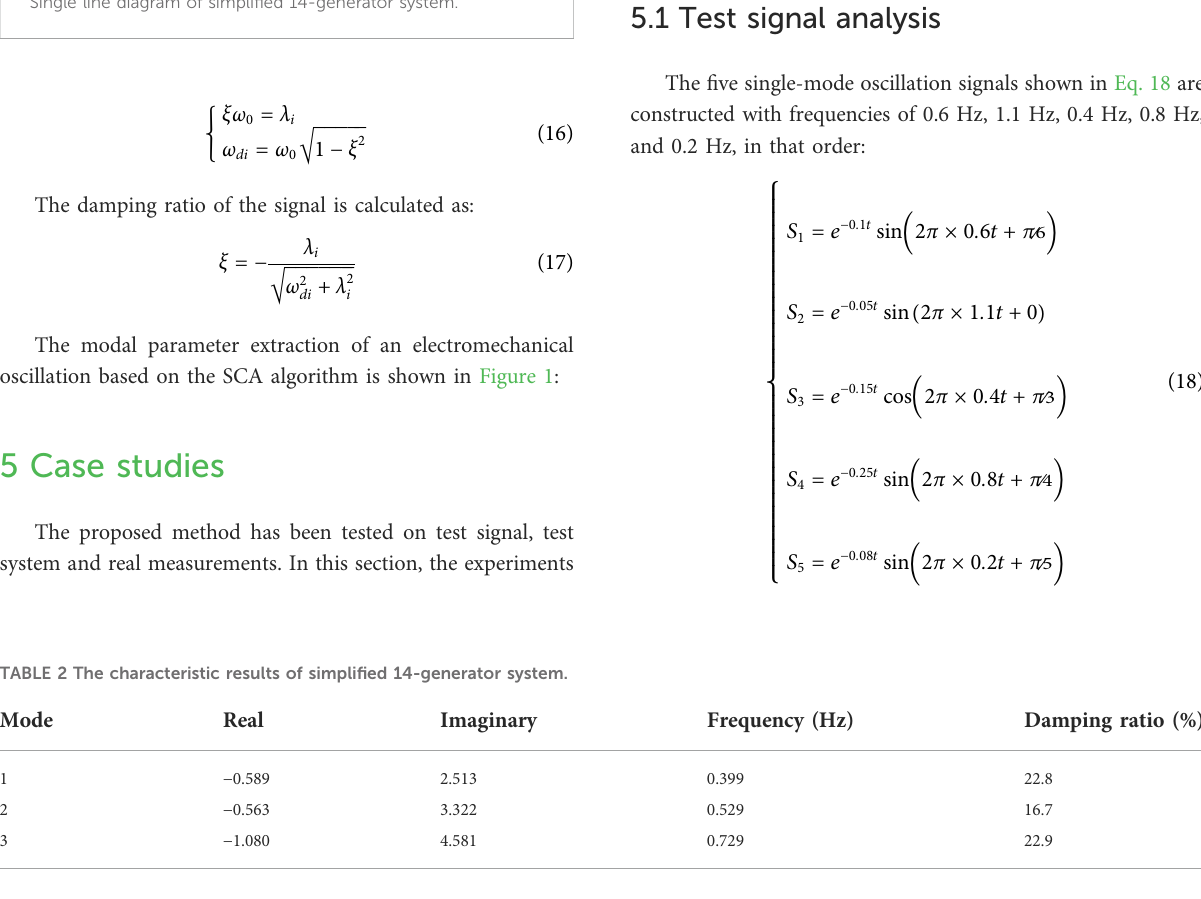
FIGURE 6 Single line diagram of simpli fi ed 14-generator system.